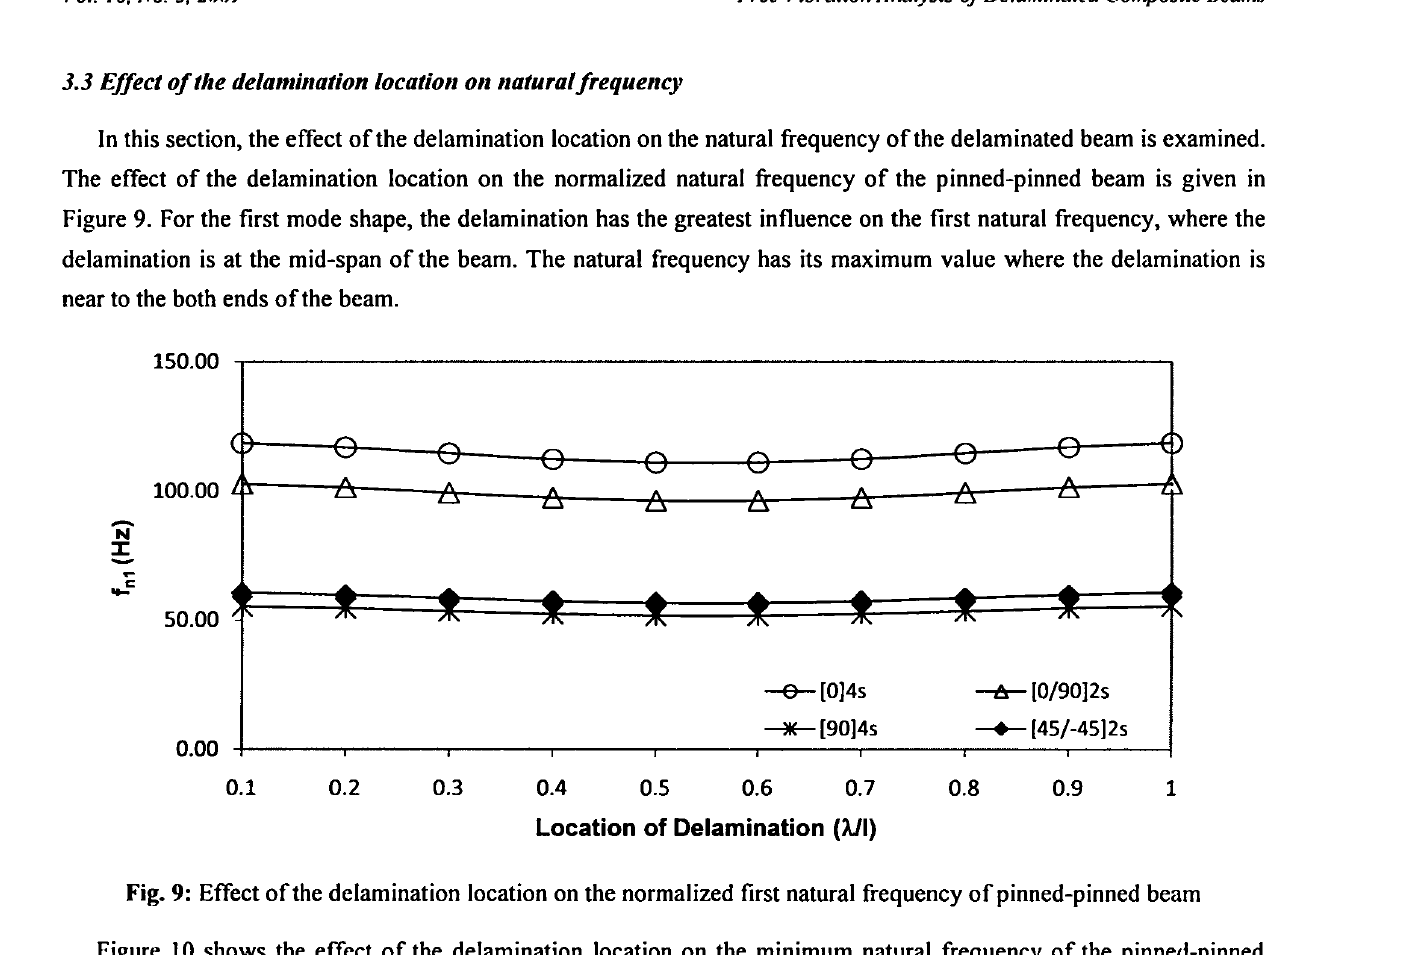
Fig. 9: Effect of the delamination location on the normalized first natural frequency of pinned-pinned beam